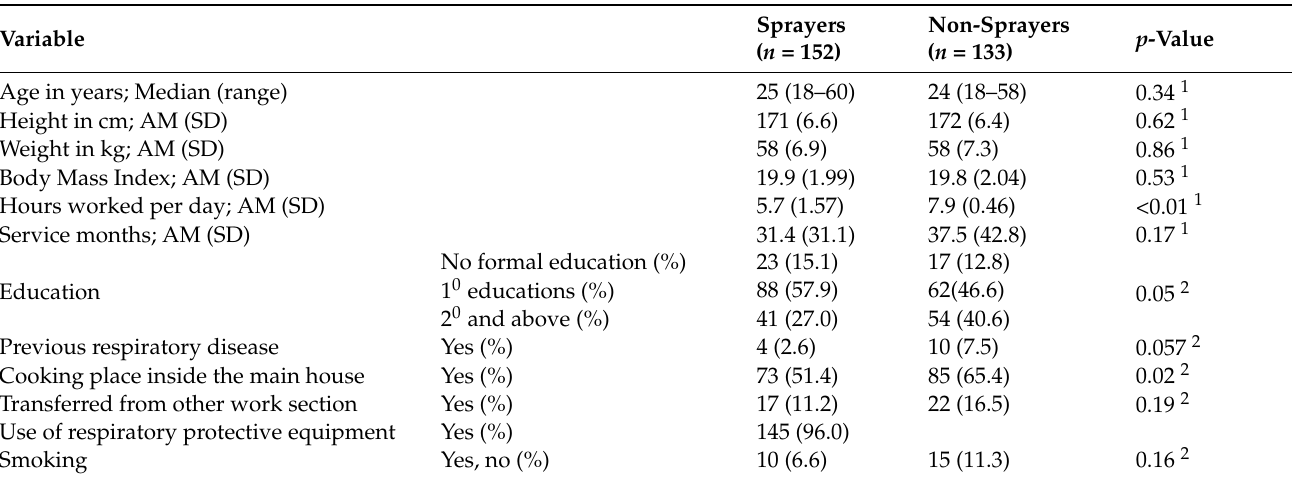
Table 2. Background characteristics of spraying and non-spraying flower farm workers in Ethiopia ( n = 285).